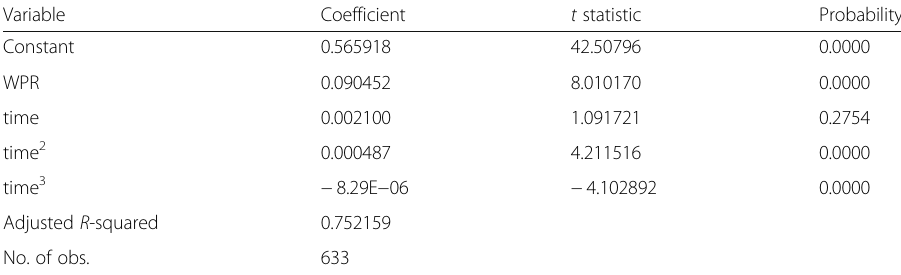
Table 20 How TFP is affected by WPR — ROECD